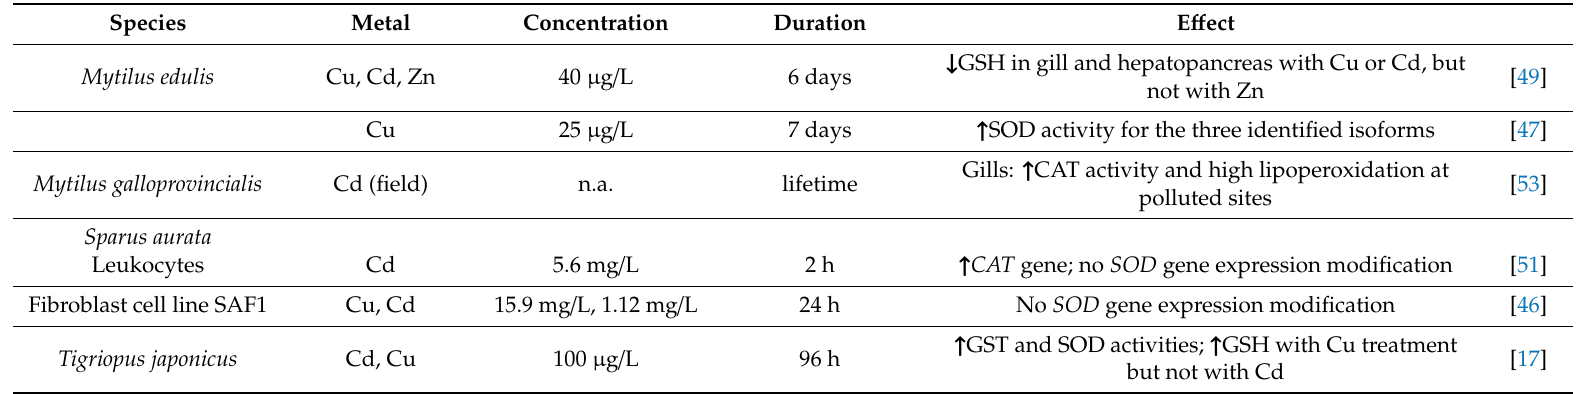
Table 2. Summary of studies describing metal impacts on redox homeostasis